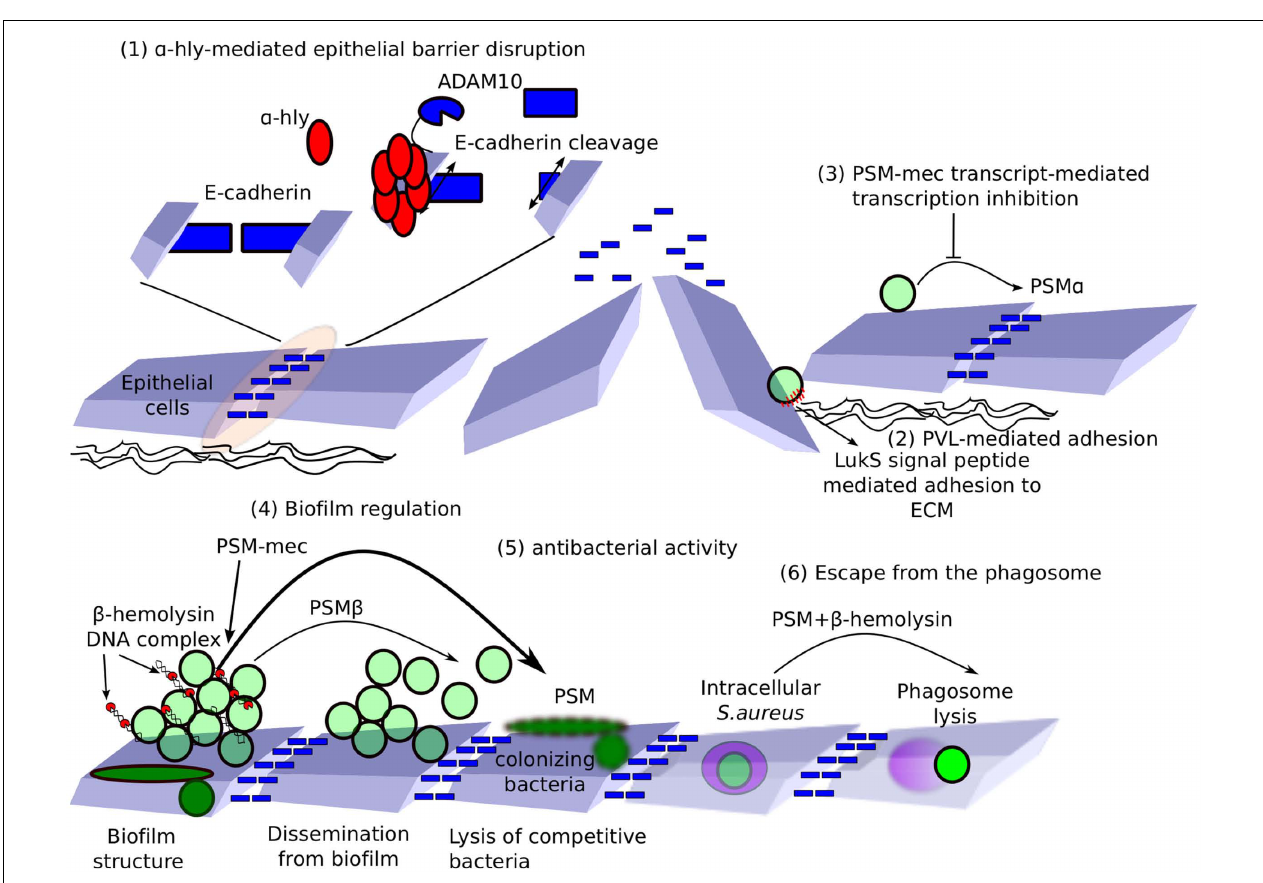
factors, including PSM α . (4) β -Hemolysin binds DNA, forming nucleoproteins nucleating S. aureus biofilm. PSM β acts as surfactant, promoting the formation of intra-biofilm tunnels and bacterial dissemination from biofilms. PSM-mec enhances biofilm formation (5) In addition, PSMs have antibacterial activity, which may be relevant in lysing competing colonizing bacteria. (6) Finally, PSMs in synergy with β -hemolysin participate in phagosome lysis and escape into the host